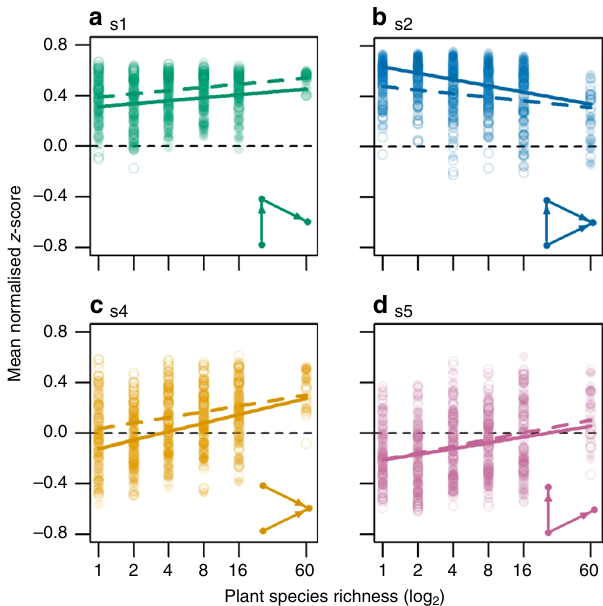
Fig. 3 Representation of motifs relative to null models. Effect of sown plant species richness on mean normalised z -scores for tri-trophic chain ( a , s1), omnivory ( b , s2), apparent competition ( c , s4) and exploitative competition ( d , s5). Filled points and solid lines show motif frequency in the full food web, and open points and dashed lines display frequency in the consumer sub-web (i.e. free- fl oating motifs). P values from linear mixed models (two- tailed test) for the slope of all displayed relationships are <0.001 (for full model results see Supplementary Table (Fig. 3a, c, d; Supplementary Table 1). In contrast, the repre- sentation of omnivory motifs signi fi cantly decreased across the gradient of plant species richness (Fig. 3b; Supplementary Table 1).